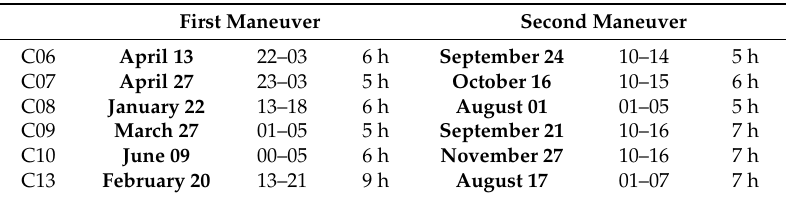
Table 3. Beidou inclined geosynchronous orbit (IGSO) satellite maneuver dates and ephemeris availability in 2017.